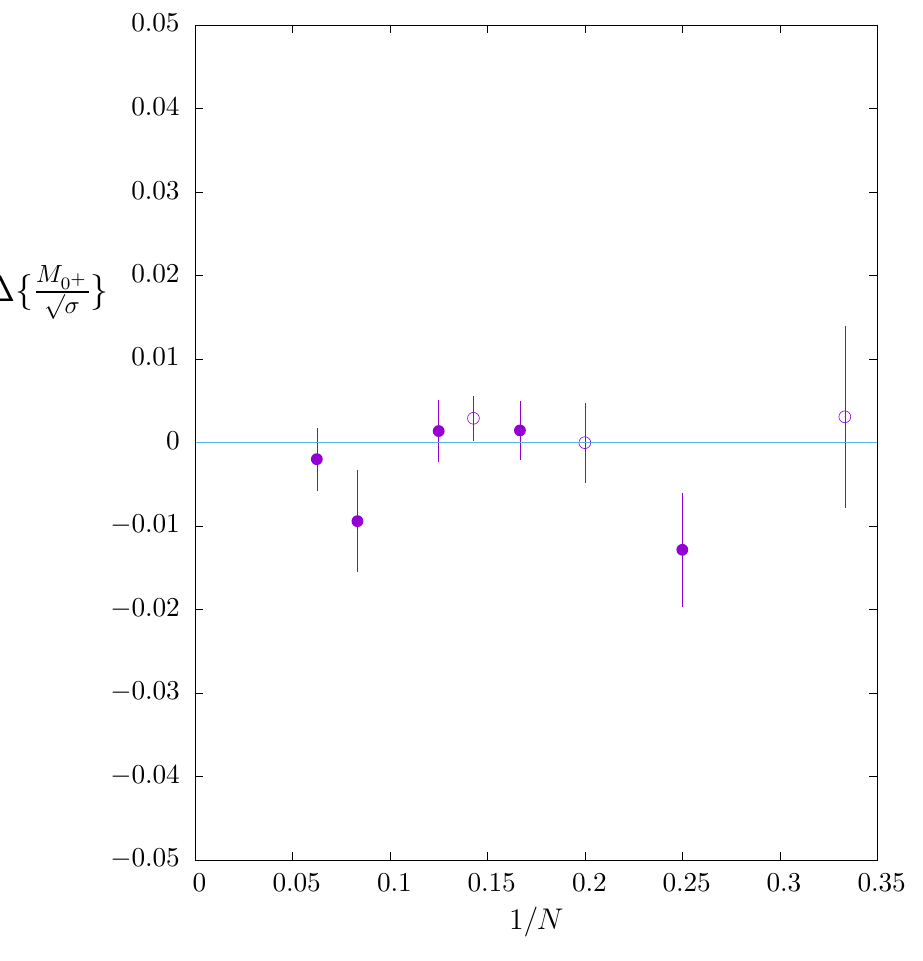
p = (cid:27) and the best (cid:12)t eq. (6.5), normalised by value of 0 +